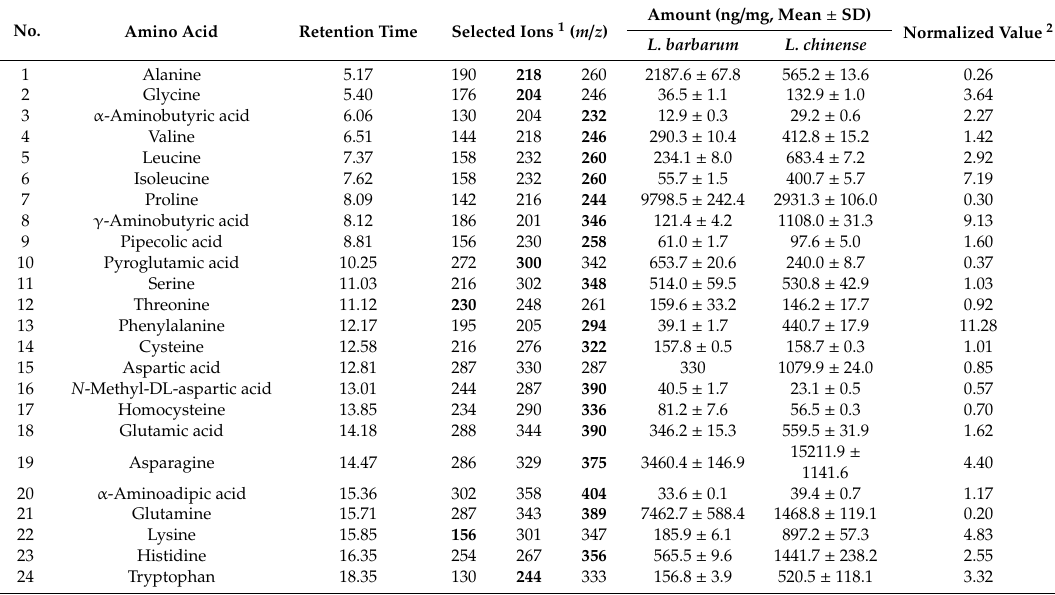
Table 1. Amino acid levels in L. chinense and L. barbarum .